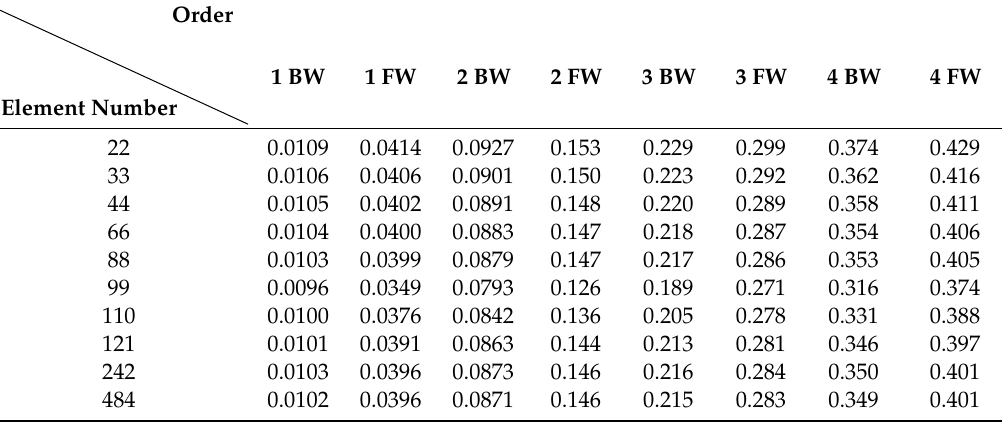
Table 13. Natural frequencies via spatial discretization ( h = 400